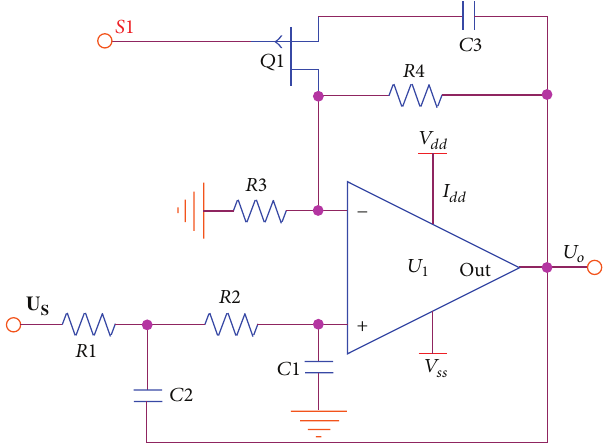
Figure 7: The Sallen-Key filter after adding switched bypass- component 𝐶3 . 𝐶3 isaddedforthepurposeofDFT,andMOSswitch 𝑄1 is used to bypass 𝐶3 in filter mode.